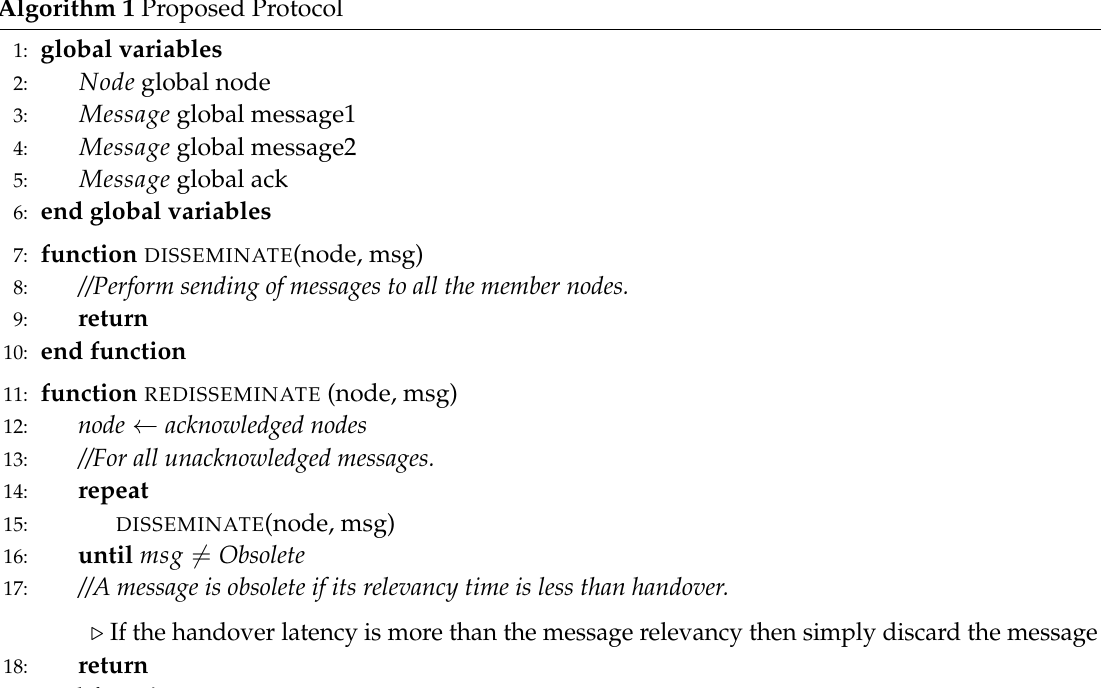
Algorithm 1 Proposed